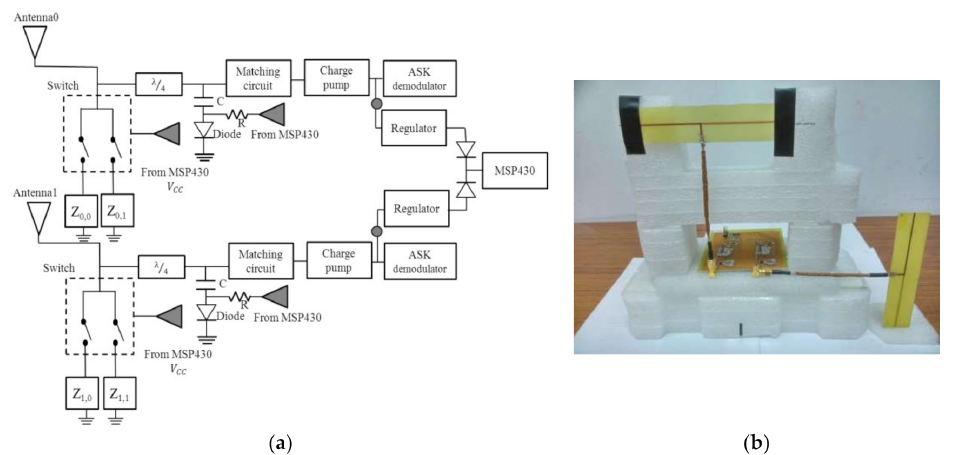
Figure 2. MIMO UHF RFID tag: ( a ) Architecture; ( b ) photograph. The front-end part of the tag is composed of two antennas shifted 90 ◦ (with polariza- tion directions orthogonal to each other) as for vertical and horizontal antenna